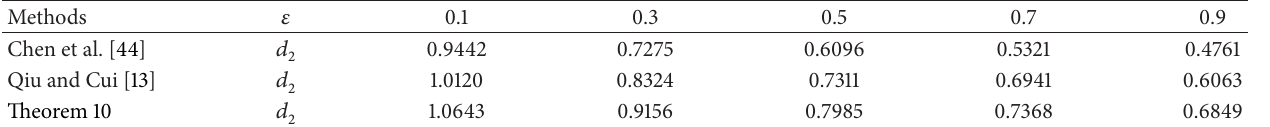
Table 6: Maximum upper bound of 𝑑 2 with different 𝜀 and parameter 𝜇 = 0.5 .